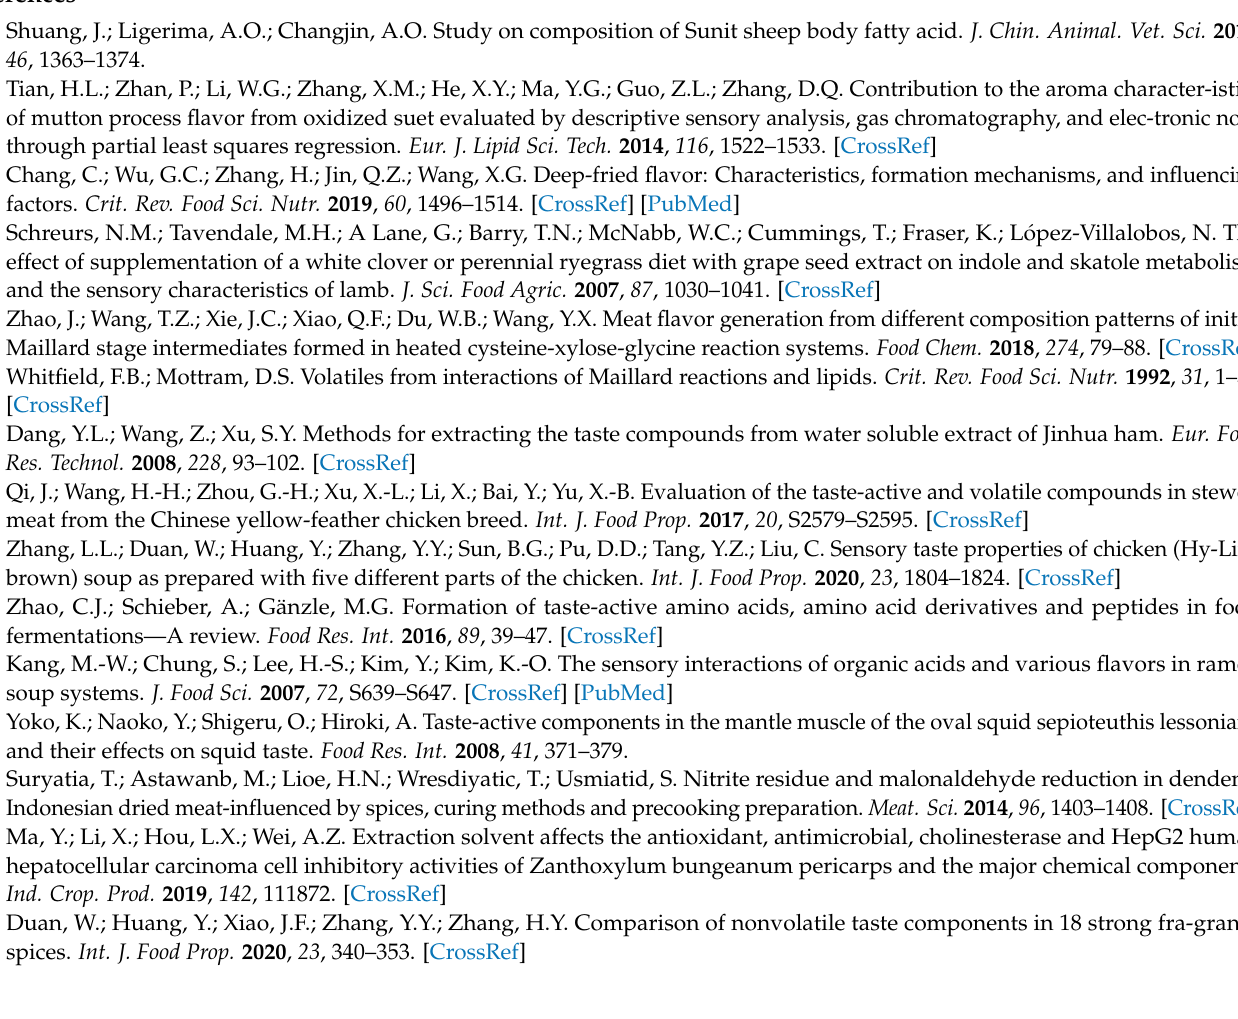
Figure S2: The proportion of three types of amino acids in stewed sheep tail fat samples, Figure S3: The EUC value of samples, Table S1: Factors and conditions for optimizing stewed sheep tail fat samples, Table S2: Taste evaluation with compounds added to taste threshold